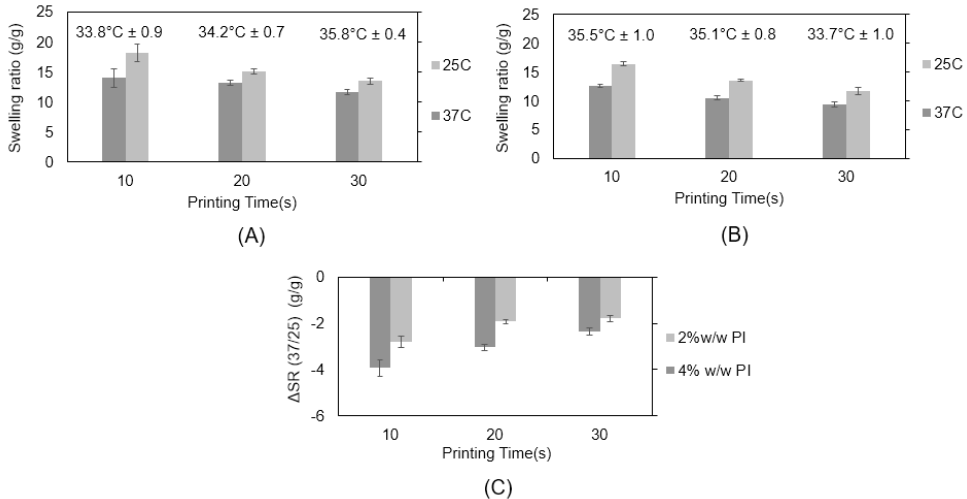
Figure 3. Swelling ratio (g/g) of 3% TMPTA N80-D15-A5 scaffold with ( A ) 2% w / w and ( B ) 4% w / w photo-initiator (Irg819). Scaffold T trans values as determined by DSC added to the graphs. ( C ) ΔSR (37/25) values of the presented formulations.